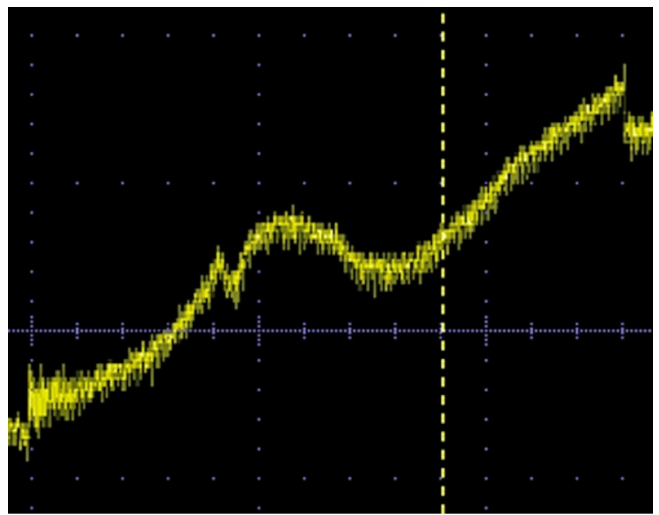
Figure 19. Display hard-copy of the measured digital oscilloscope, during the measurement of Figure